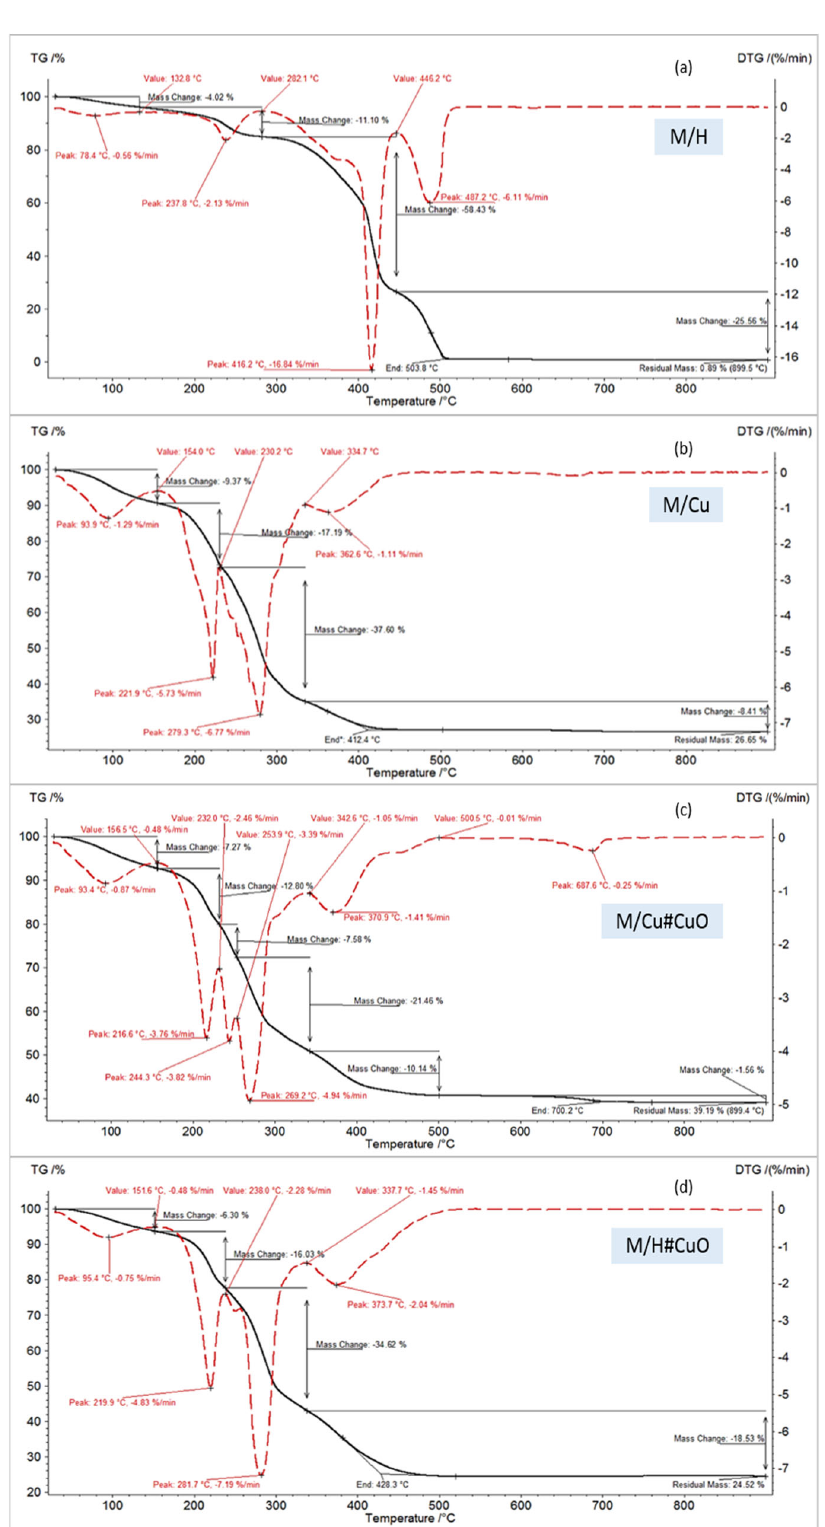
Figure 3. TG/DTG curves in air of ( a ) M/H, ( b ) M/Cu, ( c ) M/Cu#CuO, and ( d ) M/H#CuO.